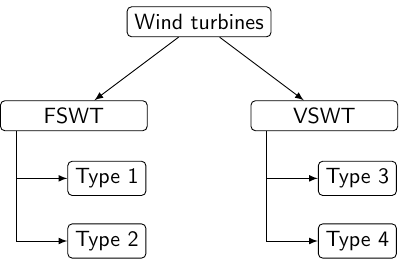
Figure 1. Classification of wind